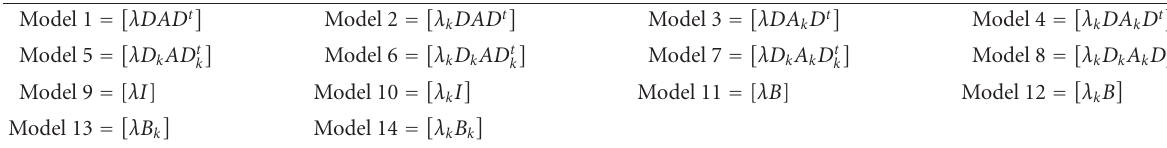
Table 1. Summary of the 14 models presented in Bensmail and Celeux [104].